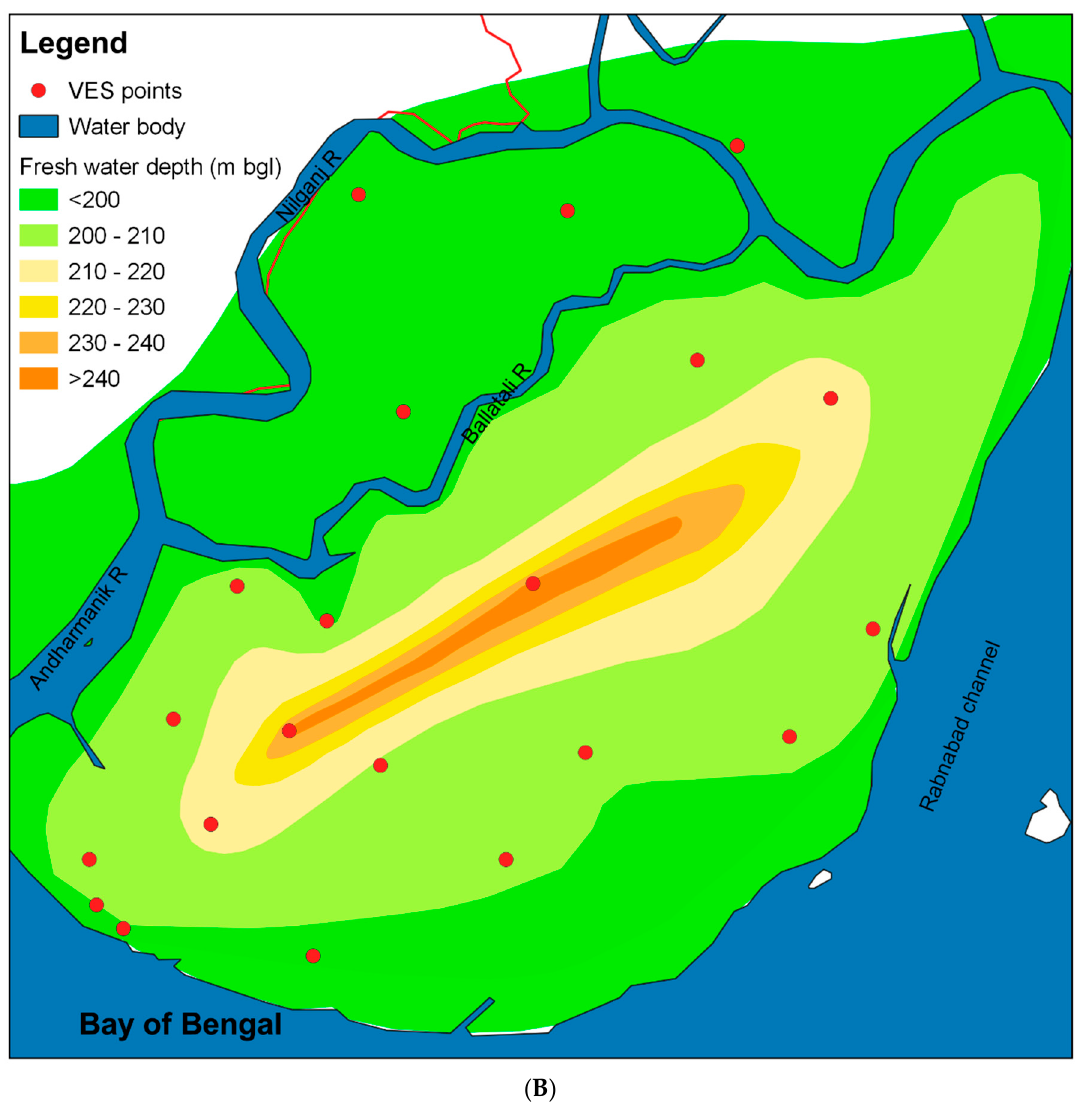
Figure 7. ( A ) Map depicting the depth to the saltwater–freshwater interface in the study area. ( B ) Saltwater–freshwater interface zoomed in within the limit of the red rectangle in Figure 7A for clarity of displaying trend of interface depth in the study area.